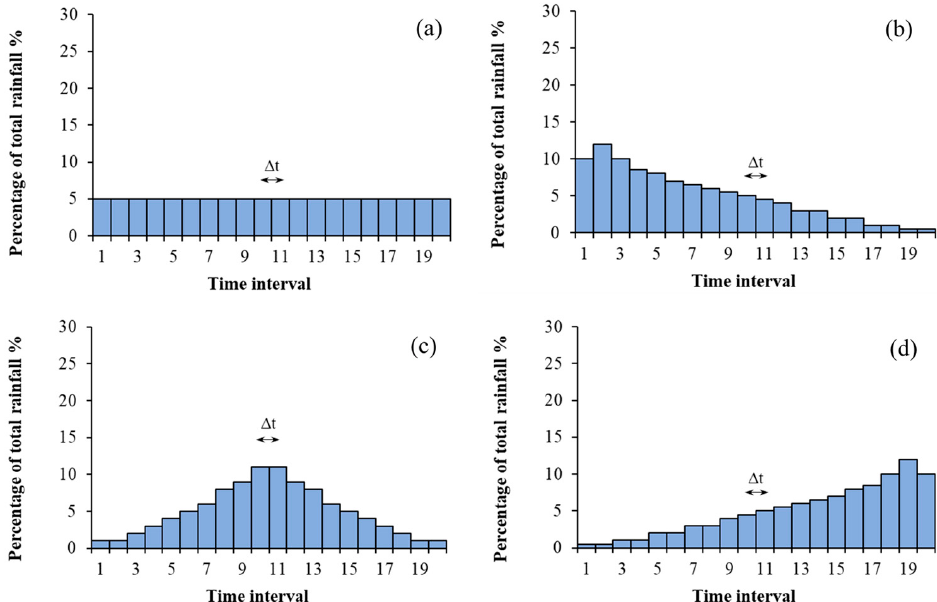
Figure 1. Typical rainfall intensity distributions with ( a ) constant intensity over time, ( b ) maximum intensity at the beginning of precipitation, ( c ) maximum intensity in the middle of precipitation, and ( d ) maximum intensity at the end of precipitation.